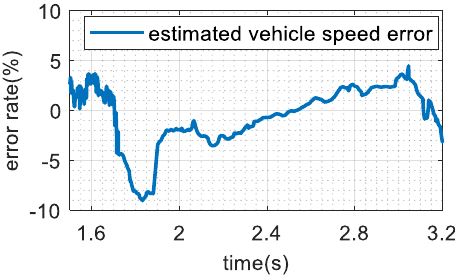
Figure 12. Estimated vehicle speed error rate.